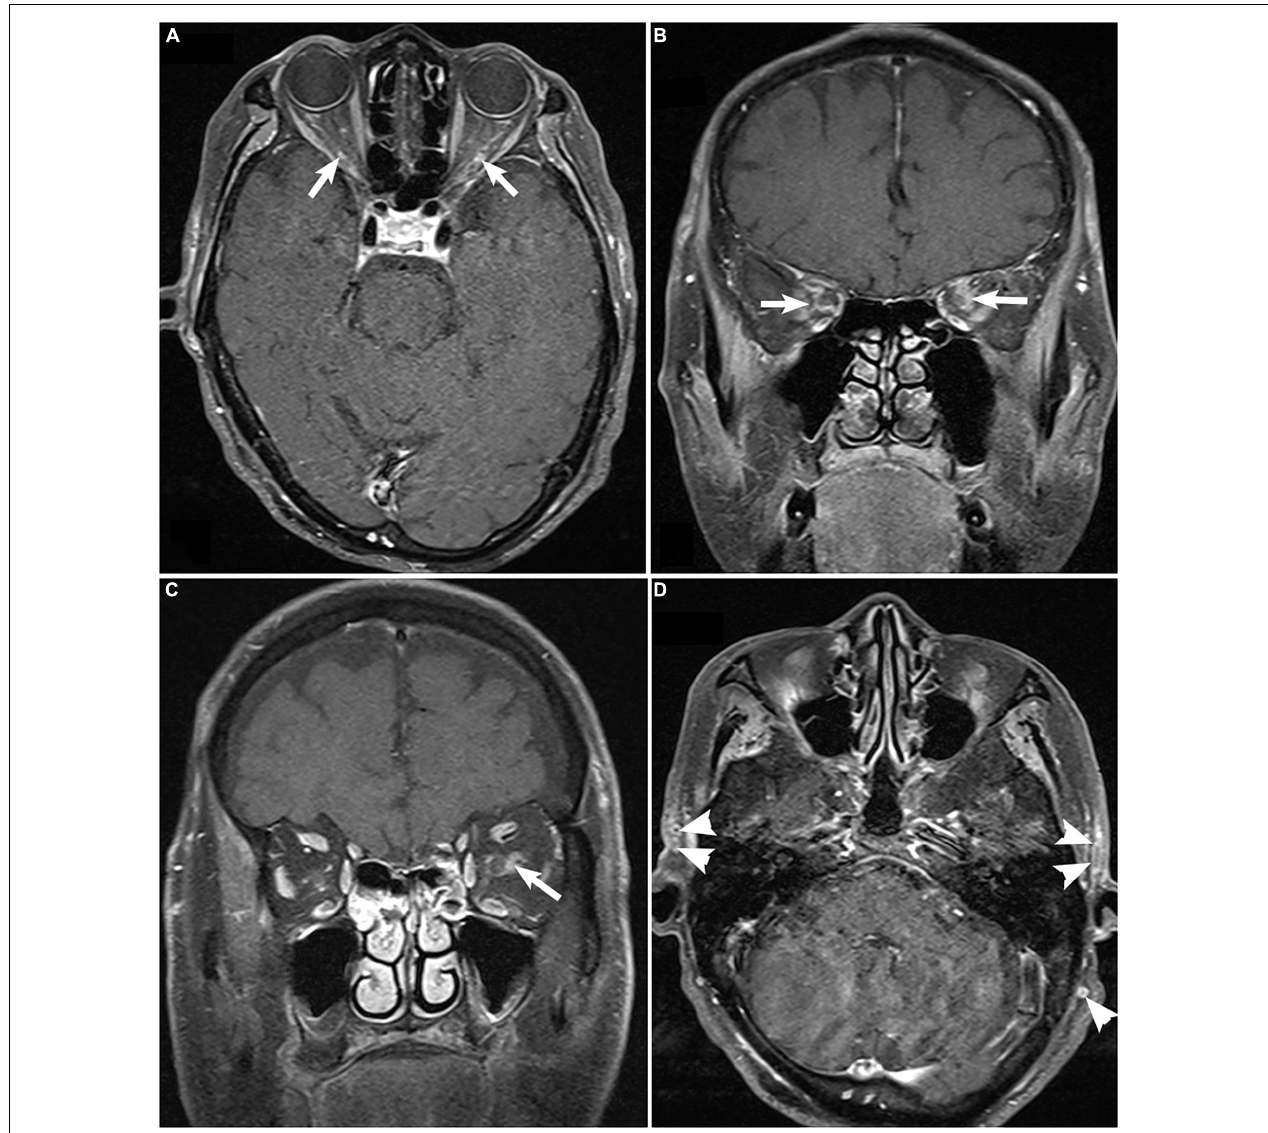
FIGURE 4 | Fat-suppressed contrast-enhanced T1-weighted magnetic resonance imaging of the orbit demonstrating enhancement of bilateral optic nerve sheaths [arrow; (A) , axial; (B) , coronal], unilateral enhancement of optic nerve sheaths [ (C) , arrow], and enhancement and thickening superficial temporal artery [ (D) ,